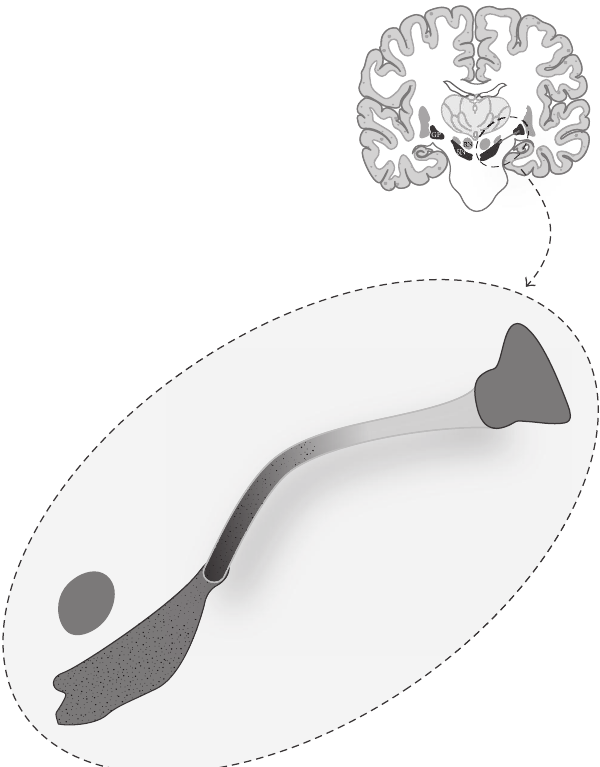
Figure 1: Illustration of the fascicula nigrale, a mineralized midbrain structure extending from the GP to the SN.